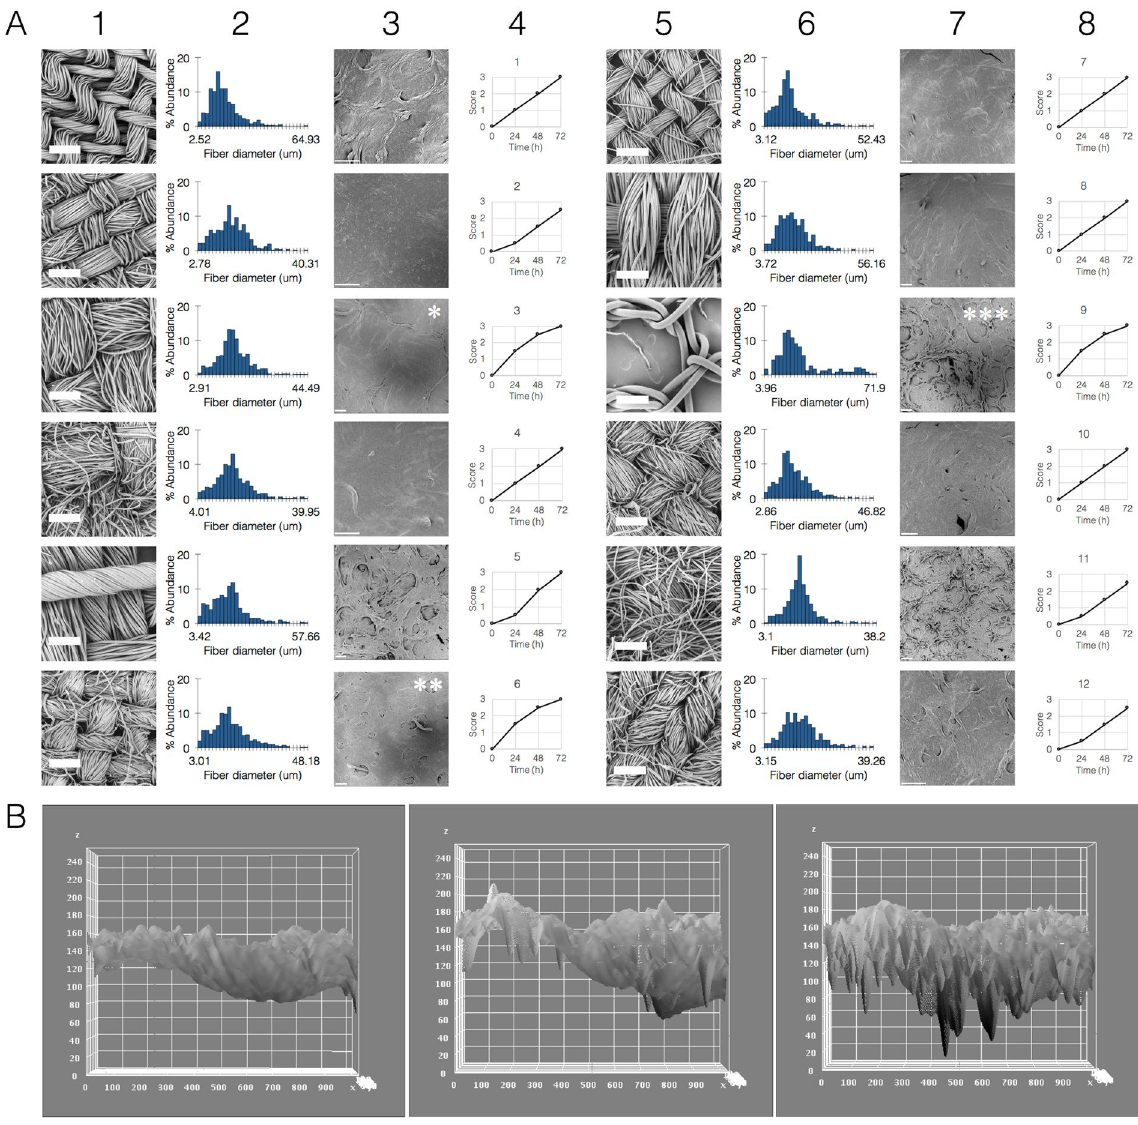
Figure 1. Fabric and hybrid analysis. ( A ) Fabric architectures (1st and 5th columns) were first examined without biofilms and unfixed using scanning electron microscope (SEM, thick scale bars = 300 µ m), and analyzed by FiberMetric (2nd and 6th columns showing fiber diameter distribution. Asterisks denote fabrics of various types which improved biofilm growth: * synthetic fabric made of polyester and cotton with large- sized threads and dense weave, ** natural fabric made of cotton with small-sized threads and plain weave, *** synthetic fabric made of polyester with large fibres and loose weave. Fabric-biofilm hybrids were fixed after 3 days in culture and visualized in SEM (3rd and 7th columns, thin scale bars = 100 µ m). Biofilm viability was scored each day on a score of 0–3 (0 = no growth and clear medium, 3 = full growth and cloudy medium, 4th and 8th columns). Control biofilm without fabric was scored 0–1–2–3. Results representative of 3 independent repeats. ( B ) Image analysis showing simulated roughness of biofilm in each of the three representative fabrics ( * , ** , *** , from left to right), demonstrating the correlation between weaving density and biofilm structure (x and y axes, location pixels; z axis, pixel intensity on a scale of